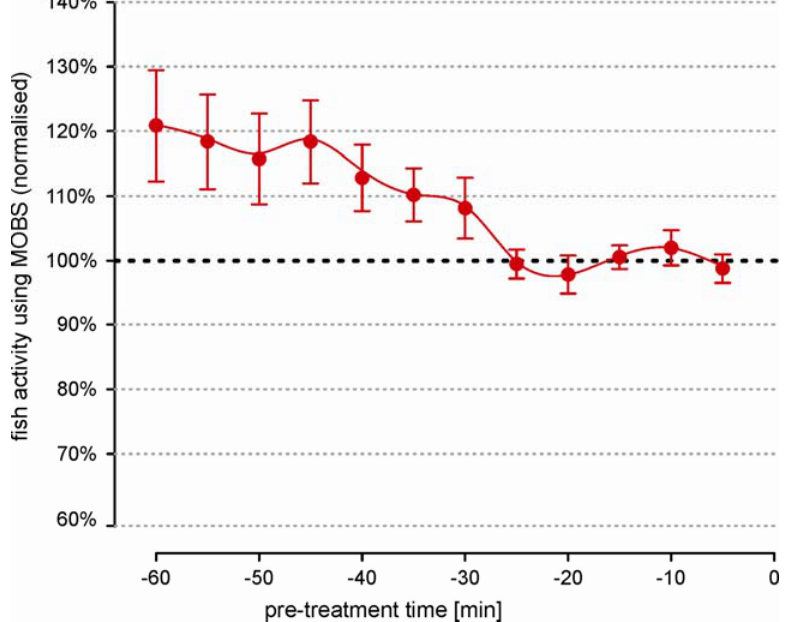
Figure 2. Pre-treatment activity of zebrafish recorded by the MOBS system. Data have been normalized to the median of readings from the last 25 min and are shown as Winsorized mean ± standard error (N = 27). Values when activity had stabilized were used to normalize the data for each